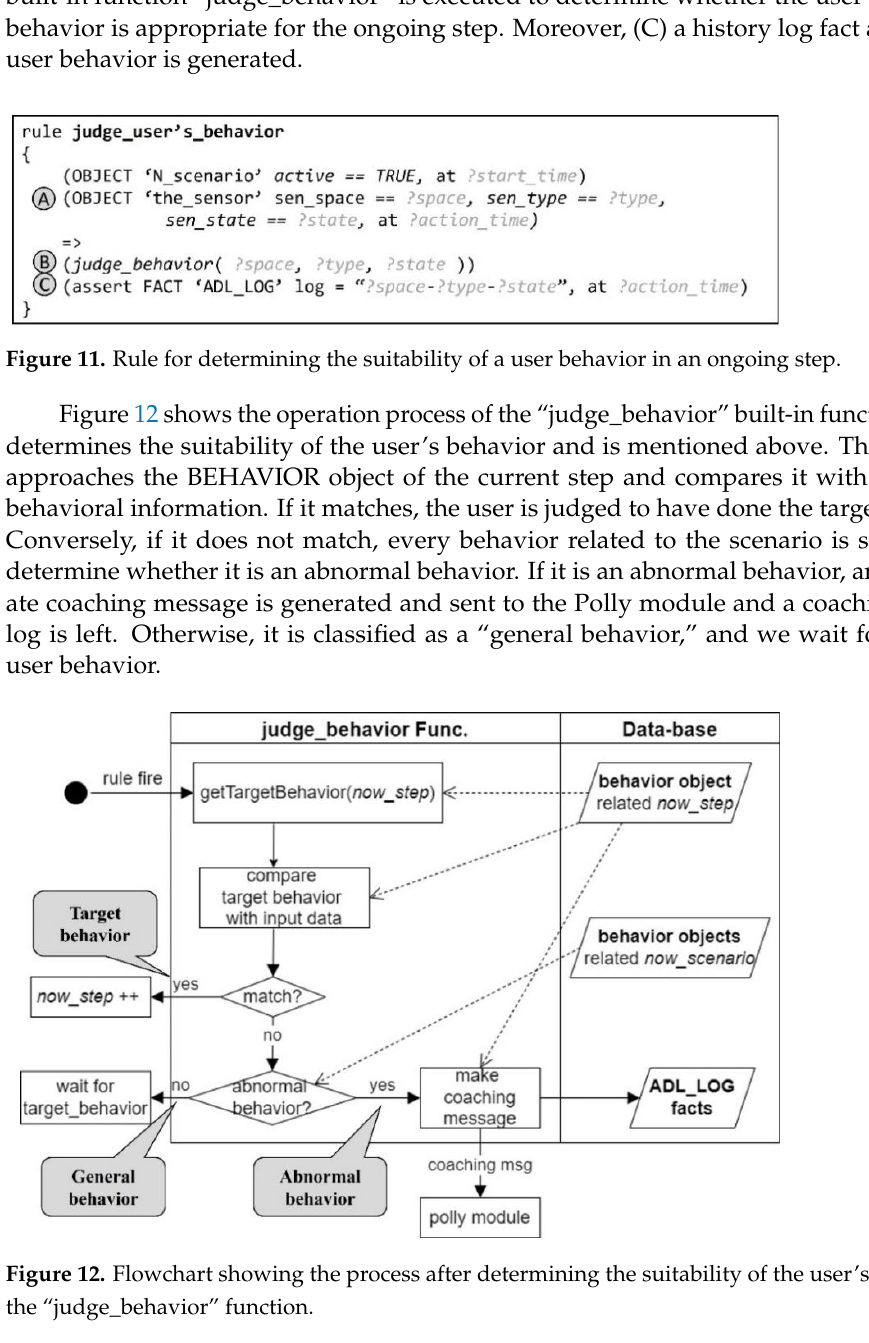
10 of 17 Figure 10. ( a ) Rule for starting an Nth scenario. ( b ) Rule for ending an Nth scenario when the user